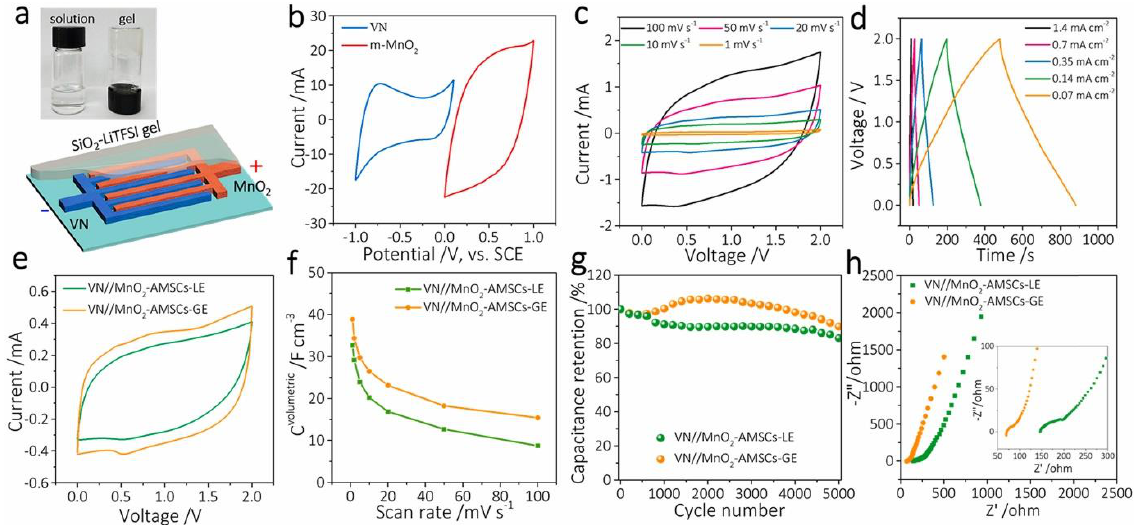
left). CV curves of ( b ) m - MnO 2 and VN electrode materials and ( c ) the fabricated device. ( d ) GCD profiles and ( e ) CV curves of the device with the gel electrolyte. ( f ) Plots of capacitance vs. scan rate, ( g ) the cycling stability, and ( h ) Nyquist plots of the VN//MnO 2 device with gel and liquid electro- lytes, respectively. Reprinted with the permission of